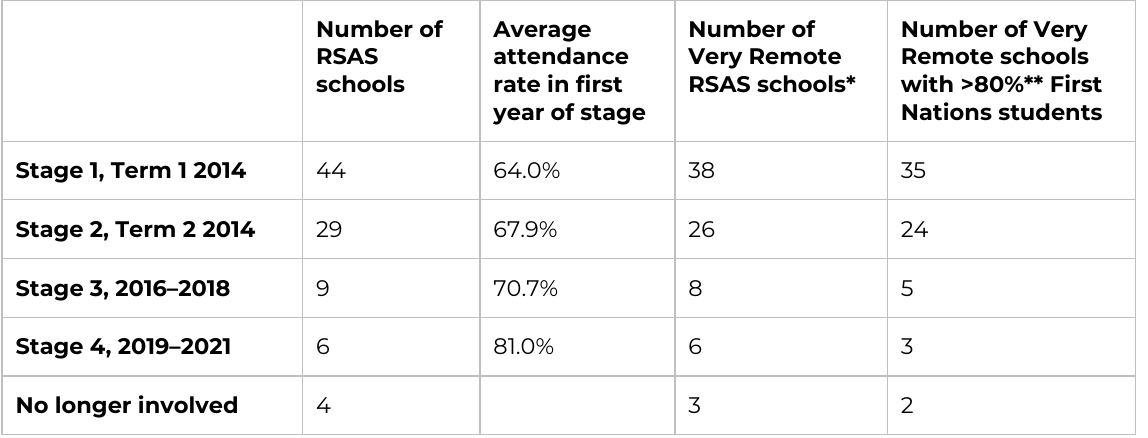
Table 1: RSAS schools by stage of introduction and comparison schools (that have not received an RSAS intervention)